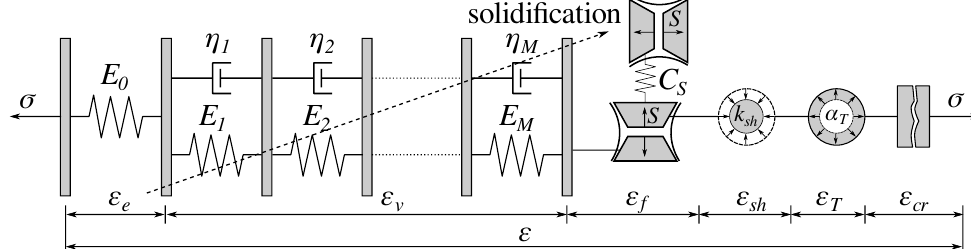
Figure 9. B3 creep model as a solidifying Kelvin chain [39]. Serial coupling with the cracking